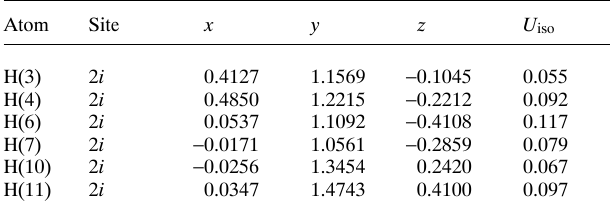
Table 2. A tomic coordin a tes a nd displ a cement p a r a meters (in Å 2 )